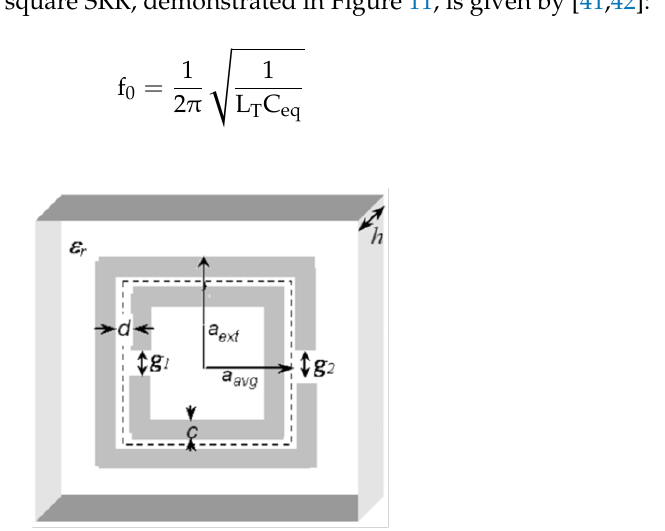
Figure 11. Schematic view of a square split-ring resonator.